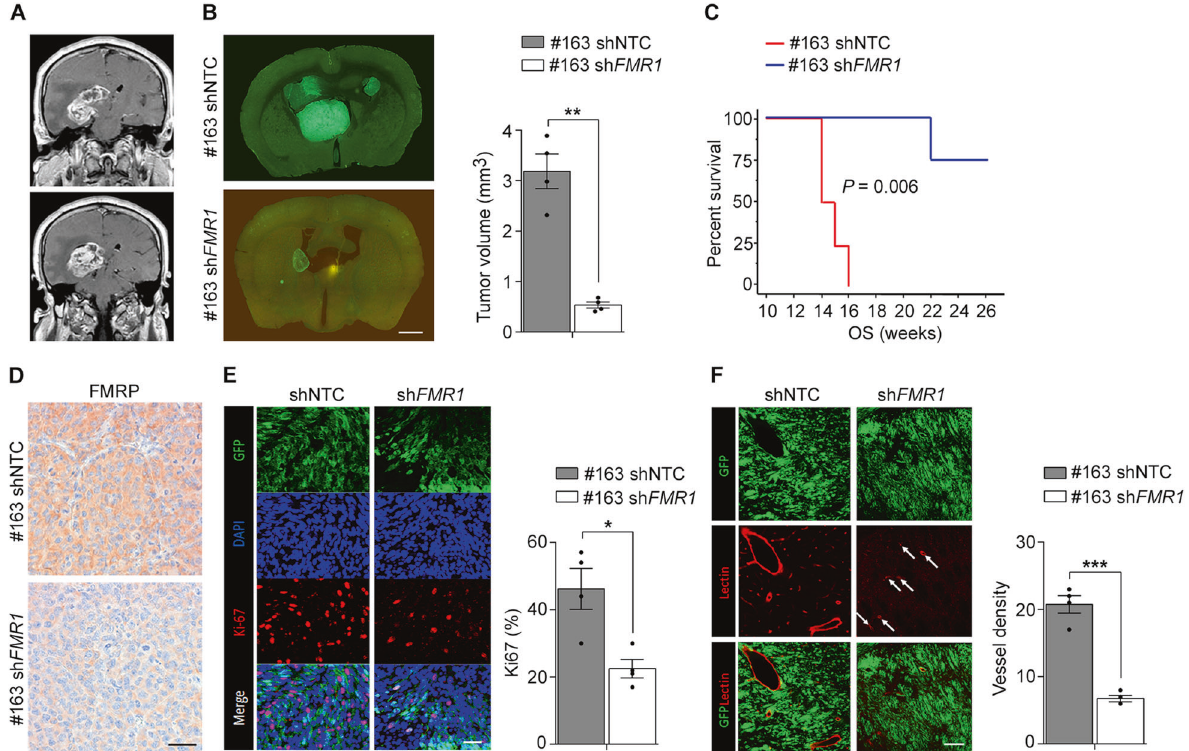
Fig. 2 FMRP levels affect tumor cell proliferation and vascularity in brain xenografts. A Gadolinium-enhanced T1-weighted coronal magnetic resonance of the patient the GSC#163 line was generated from. B The left panel represents coronal brain sections of shNTC GSC#163 and sh FMR1 GSC#163 grafts, where the latter showed remarkable tumor growth reduction. Right panel shows tumor volume quanti fi cation (mean ± SEM, n = 4/groups, ** P < 0.01, Student ’ s t -test). Scale bar, 800 µm. C Kaplan-Meier plot showing the survival of mice grafted with shNTC GSC#163 (red line; n = 4 mice; median survival 15 weeks) and sh FMR1 GSC#163 (blue line; n = 4 mice; median survival 24 weeks) ( P = 0.006, log-rank test). D Immunohistochemistry with anti-FMRP antibody shows a lower signal in GSC #163 sh FMR1 xenografts compared to GSC #163 shNTC xenografts. Scale bar, 40 µm. E Left panel, representative anti-Ki67 immunohistochemistry (red) and DAPI (blue) of tumors derived from shNTC GSC#163 and sh FMR1 GSC#163 grafts, expressing GFP (green). Scale bar, 30 µm. Right panel, quanti fi cation of Ki67 labeling index. (mean ± SEM, n = 4/groups, * P < 0.05, Student ’ s t -test). F Left panel, brain microvessels (red) were detected with Lectin. Scale bar, 45 µm. Right panel, quanti fi cation of the number of microvascular structures per microscopic fi eld (mean ± SEM, n = 4/groups, *** P < 0.001, Student ’ s t